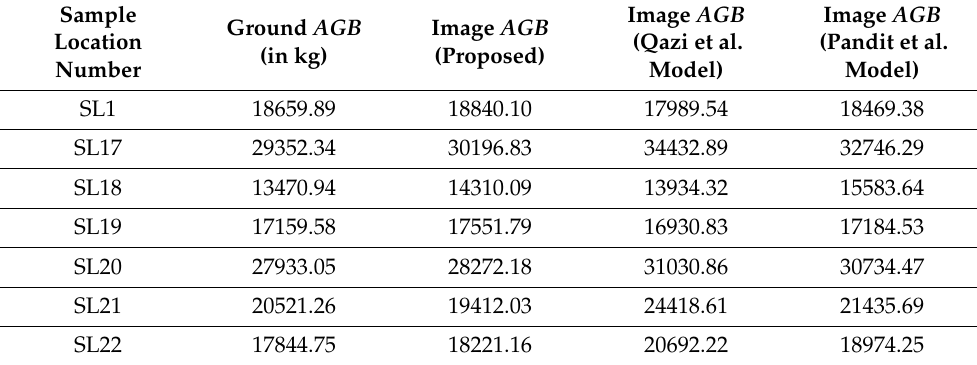
Table 6. Comparison and validation of the image retrieved forest AGB with ground forest AGB